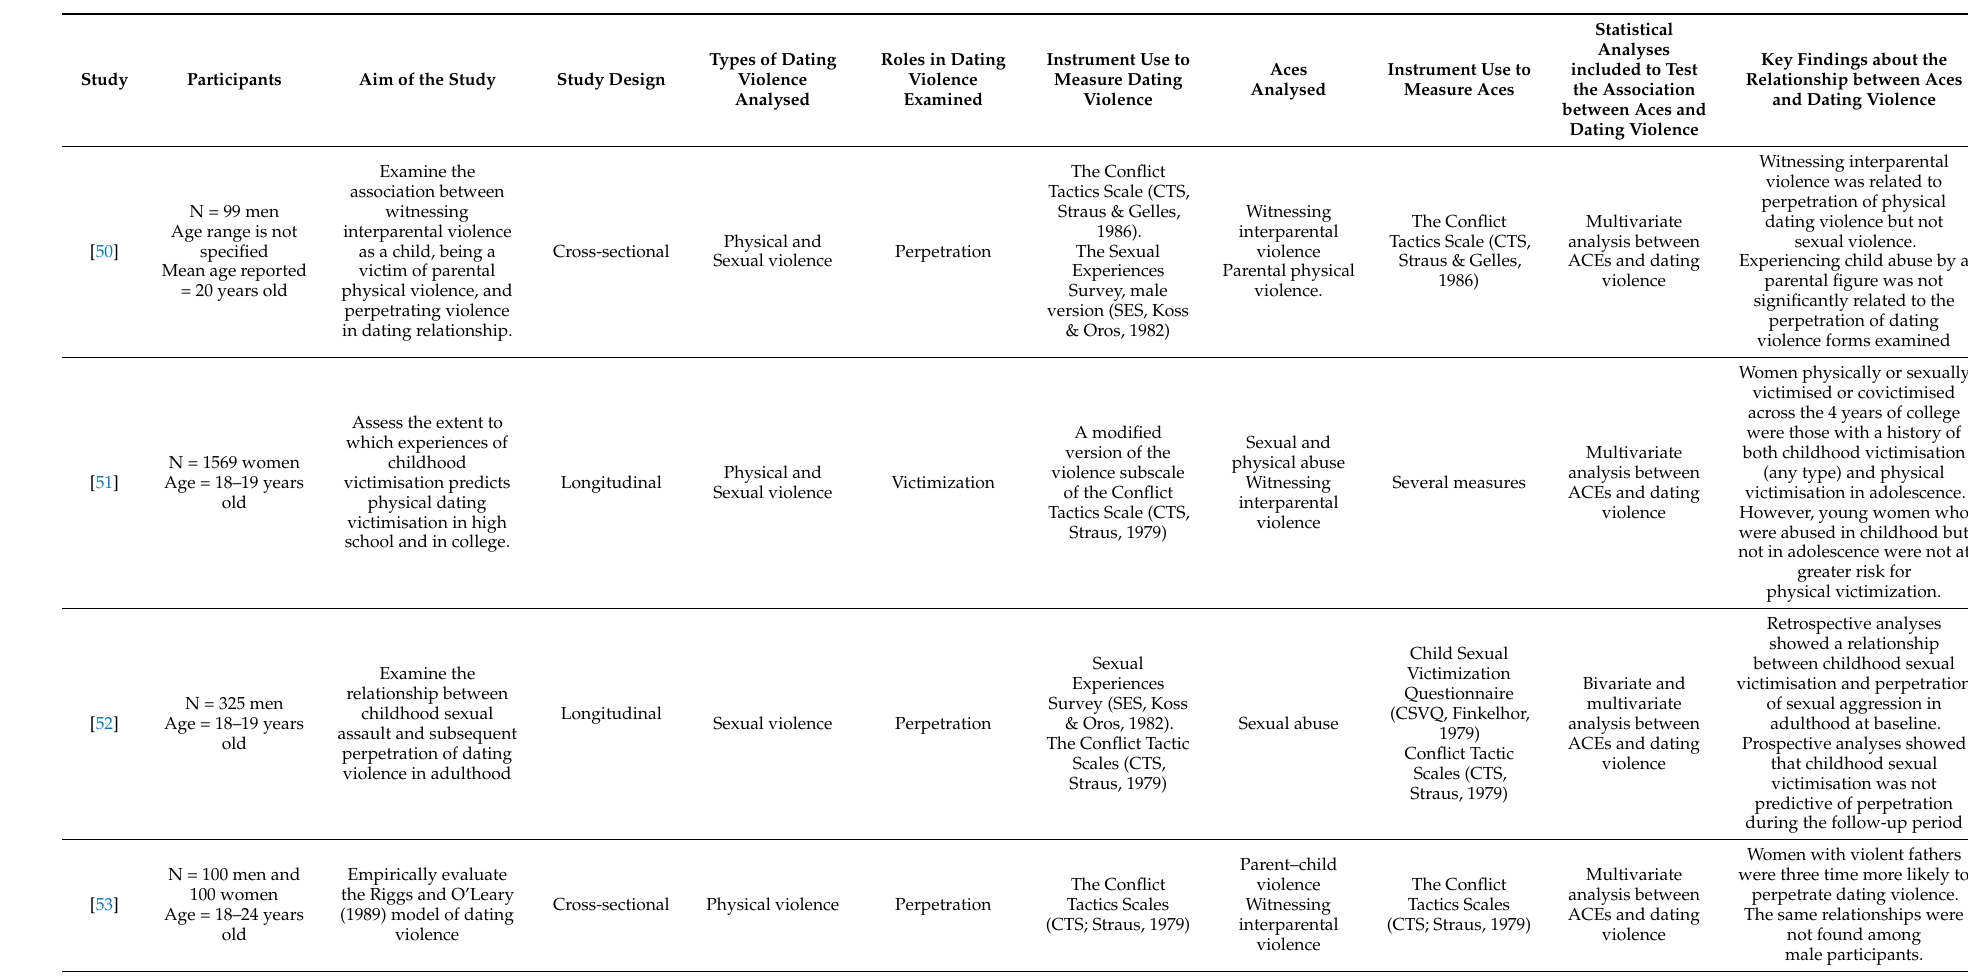
Table A1. Summary of data from articles included in the scoping review (n =